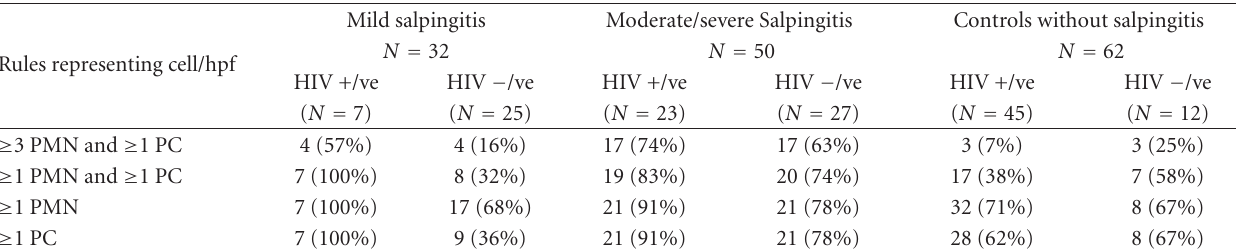
Table 3: Presence and density of polymorphonuclear leucocytes (PMN) and plasma cells (PC) on histopathology of endometrial biopsies in women with mild, moderate, and severe salpingitis at laparoscopy and controls in HIV-seropositive and -seronegative women.